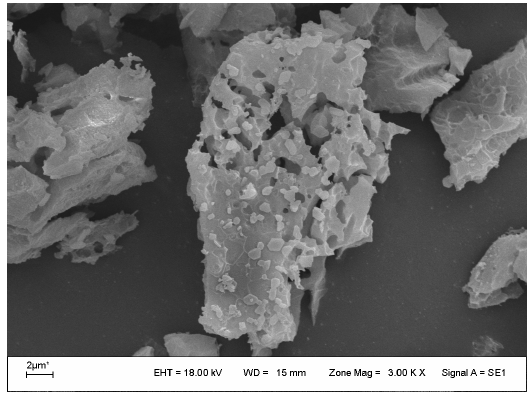
Figure 8. SEM micrographs of the leaching residue ( X : 0.2; time: 1 min; and temperature: 308 K). Table 2. EPMA analysis, in at %, corresponding to leaching residues obtained at different temperatures. Temperature (K)